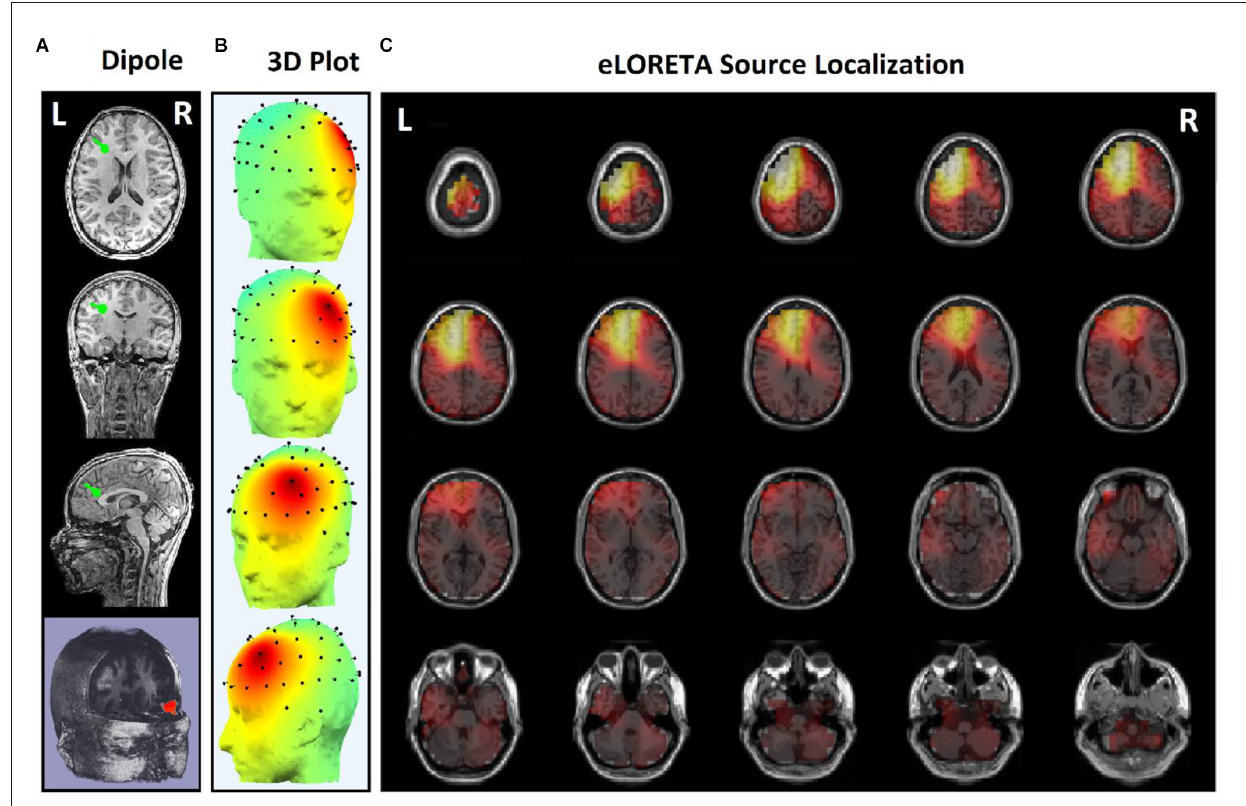
FIGURE5 Source localization of rTMS stimulation foci in left prefrontal cortex (L-DLPFC) for a responder subject. (A) Dipole coordinates of the identified focus in left side on a default MRI. (B) Position of foci identified by ICA on the surface of the skull. (C) Source localization in right DLPFC by